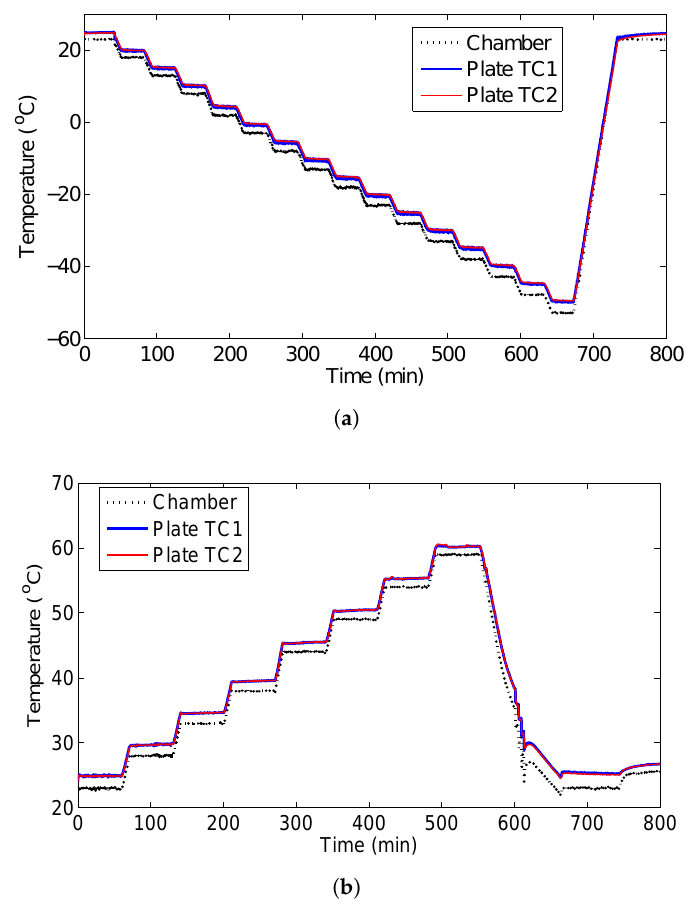
Figure 2. Recorded temperature profile for the chamber and two points on the plate (Thermocouple TC1 and TC2) for the steady state thermal tests: ( a ) low temperature; ( b ) high